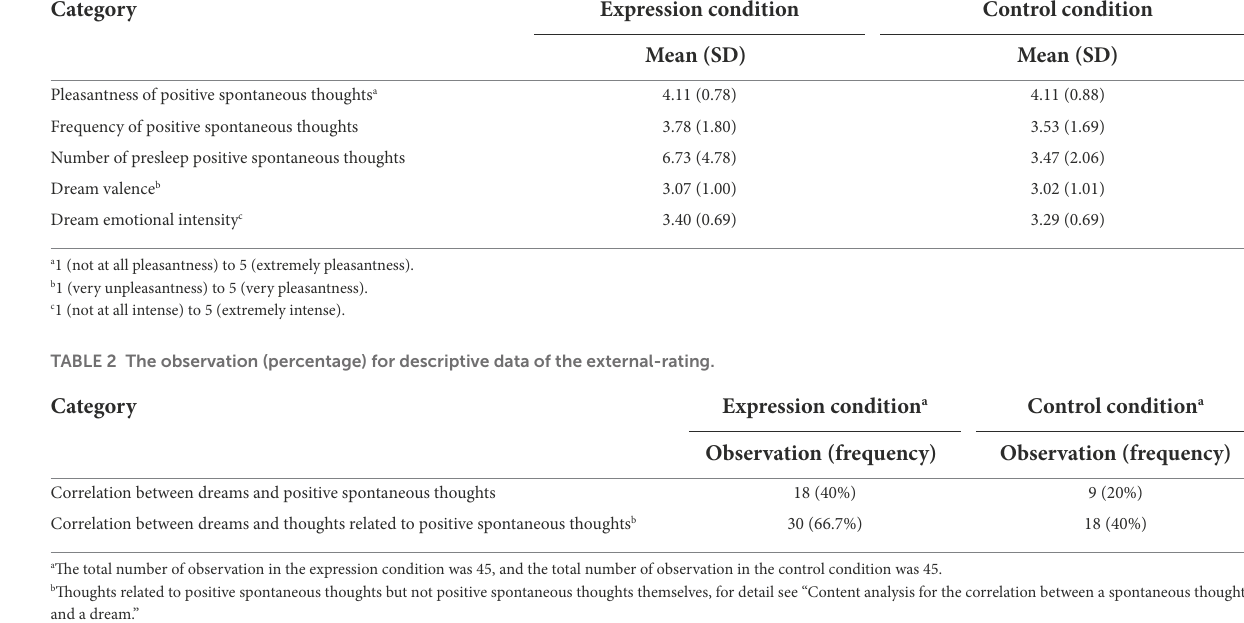
TABLE 1 Mean (SD) for descriptive data of different variables of the self-rating.